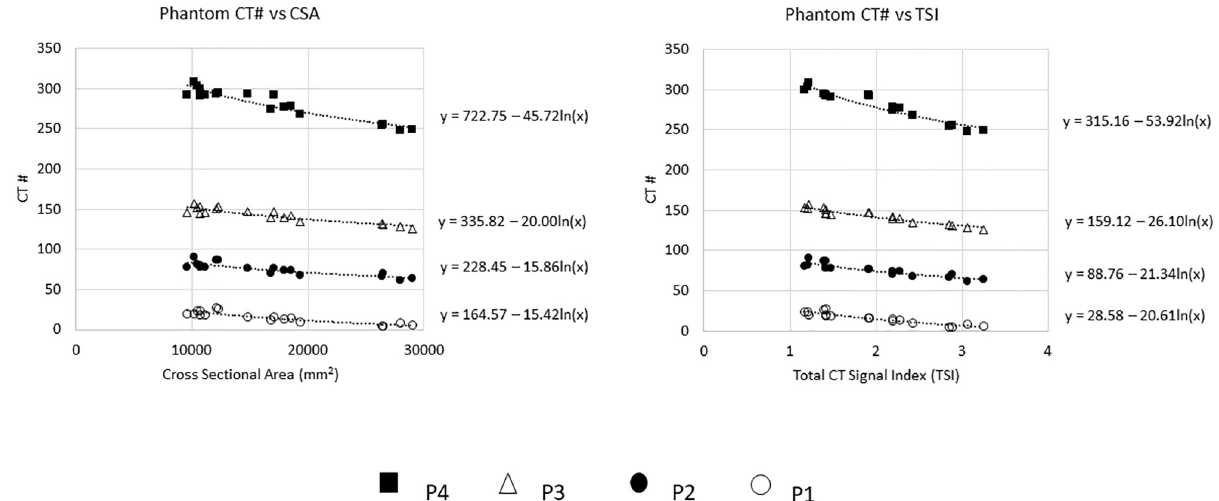
Fig 2. CT numbers and total signal index. Phantom ROI CT# versus CSA(left) and TSI(right) with regression of ln(size index). These plots show that CT# decreases as subject size increases in phantom ROIs of different densities. For this scanner, one obtains an equation for the relationship between CT# and subject size of the form: CT# = B–A ln(size index) (Equation 1). The constant coefficient B in the equation 1 is equal to the CT# of the phantom ROI when the slice has a size index of 1. The magnitude of the coefficient in the ln term (A) increases as the density of the phantom increases. Akaike’s Information Criterion (AIC) was used to compare the fit of CT# vs CSA to the fit of CT# vs TSI. TSI explained more size dependent variation in CT number than area, as evidenced by the lower AIC (AIC = 380.6 for CSA vs 360.5 for TSI).